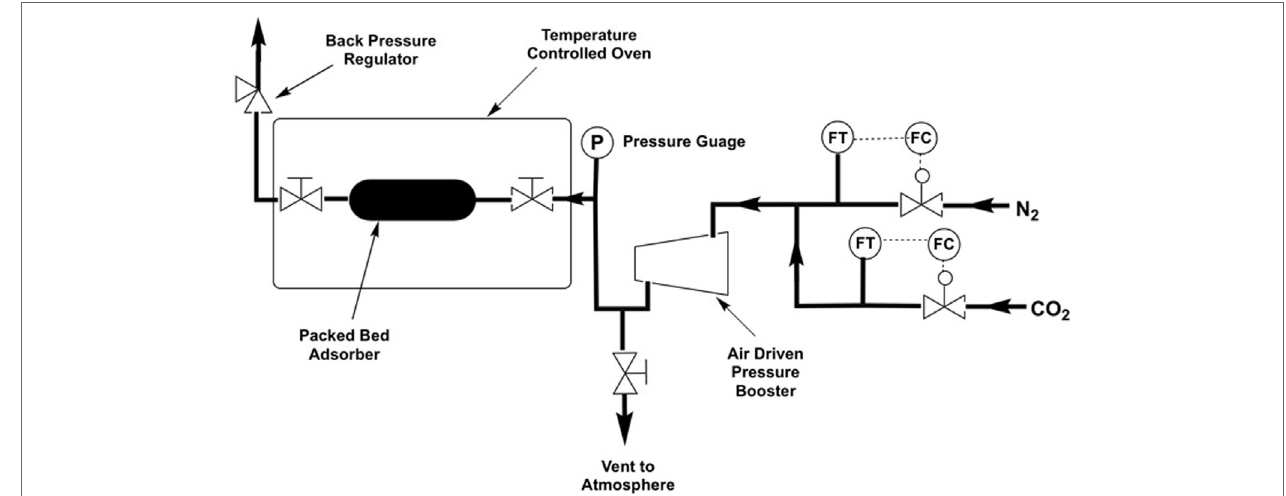
FigUre 2 | Simplified process flow diagram of the experimental